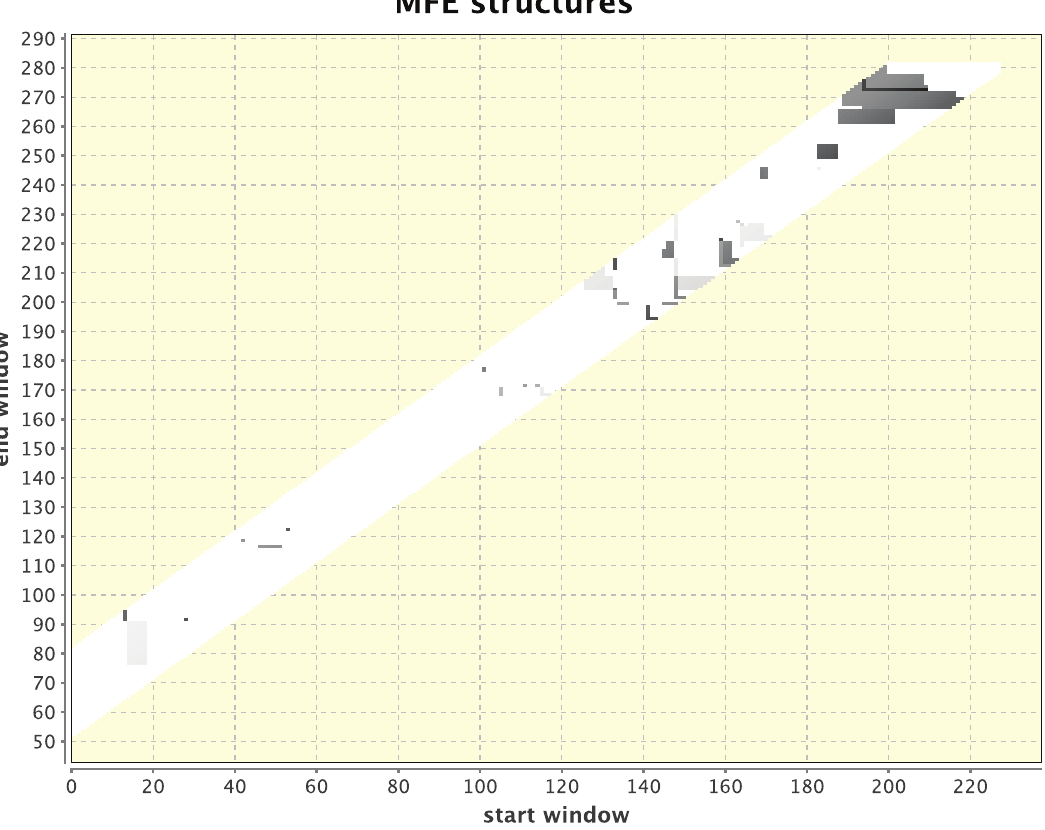
Figure 3. Simulated heat-shock response for a sequence containing the E.coliibpA RNA thermometer. A clustering of dots indicating an RNA thermometer is